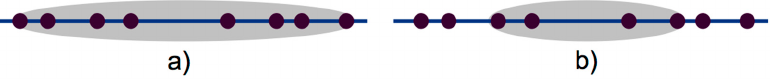
Figure 4. Visual representation of both contradicting objectives in data coverage, where ( a ) complete experimental data coverage is obtained; and ( b ) a limited coverage of experimental data is obtained.